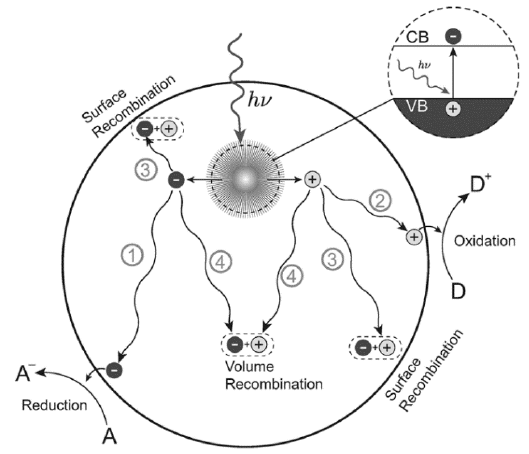
Figure 1. Formation of electron–hole pairs in semiconductor materials. Reprinted with permission from [33]. Copyright 2013, Wiley.